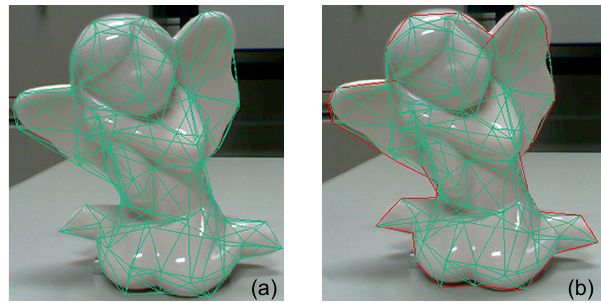
Fig. 1. In (a), a sparse mesh is rendered on the target object resulting in (b) a coarse representation of the object contour (red